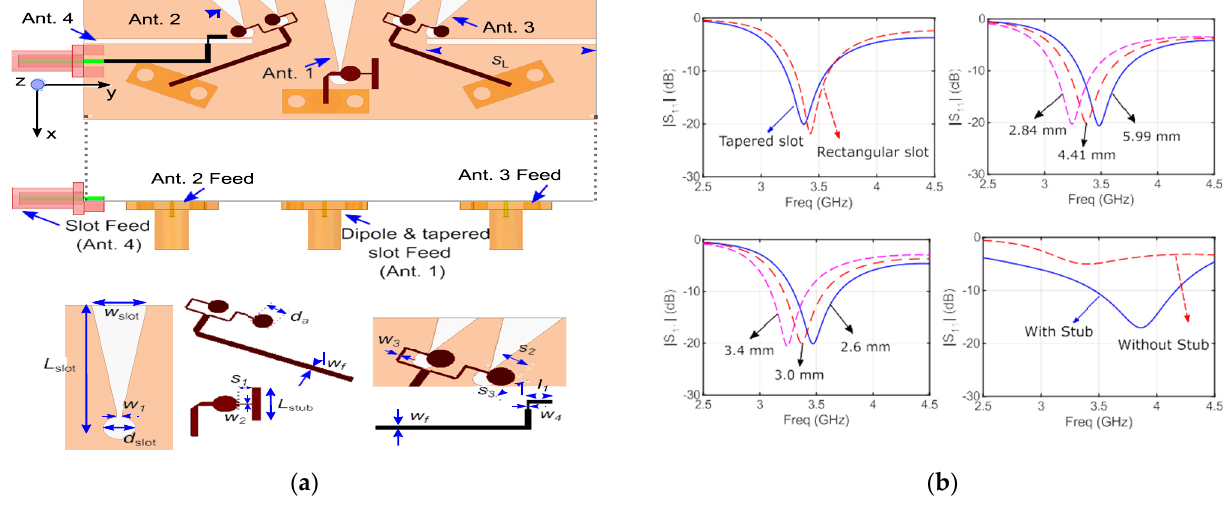
Figure 7. ( a ) The design geometry of sub-6 GHz and mm wave common aperture 5G antenna system [36] and ( b ) results.